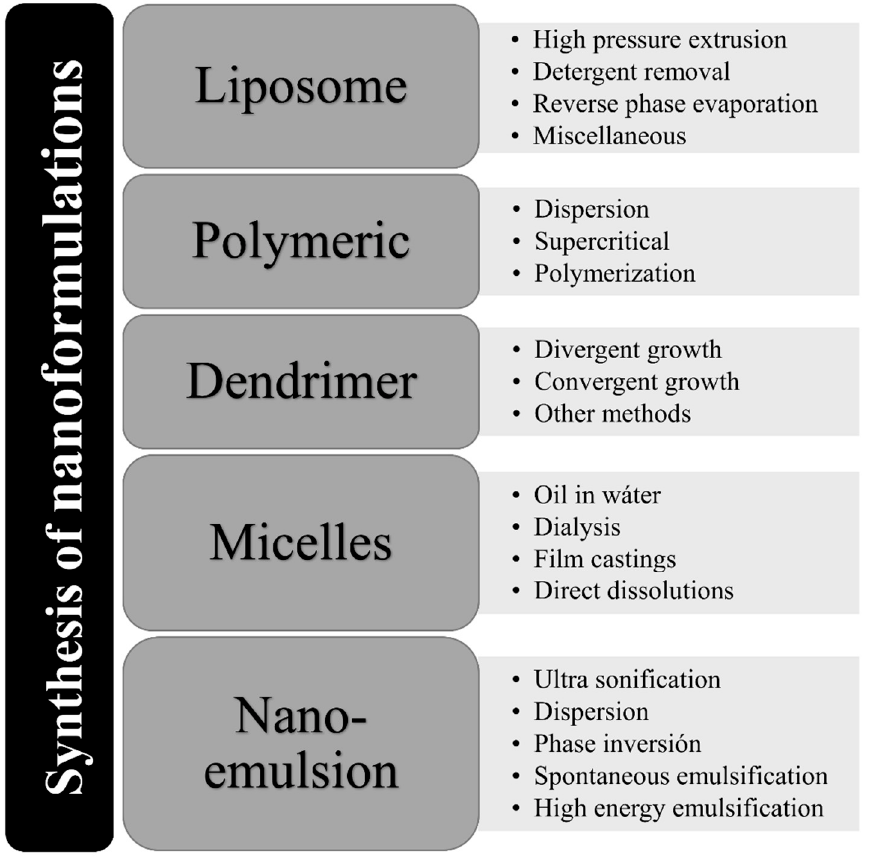
Figure 4. Di ff erent types of synthesis of Figure 4. Different types of synthesis of nanoformulations.